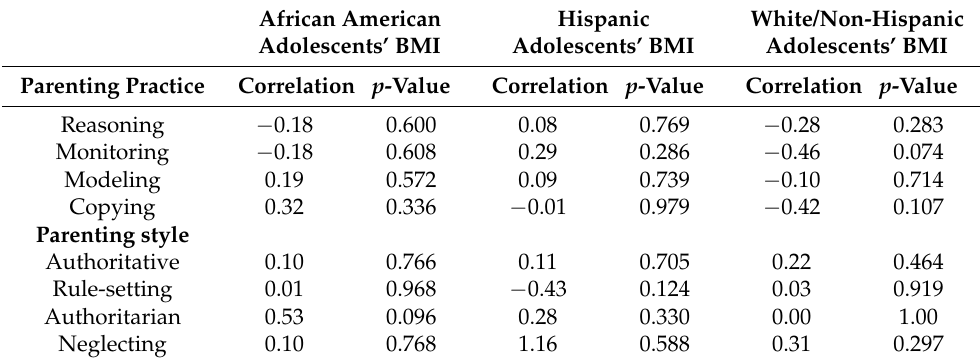
Table 6. Correlation between parenting practices and adolescent BMI percentiles by